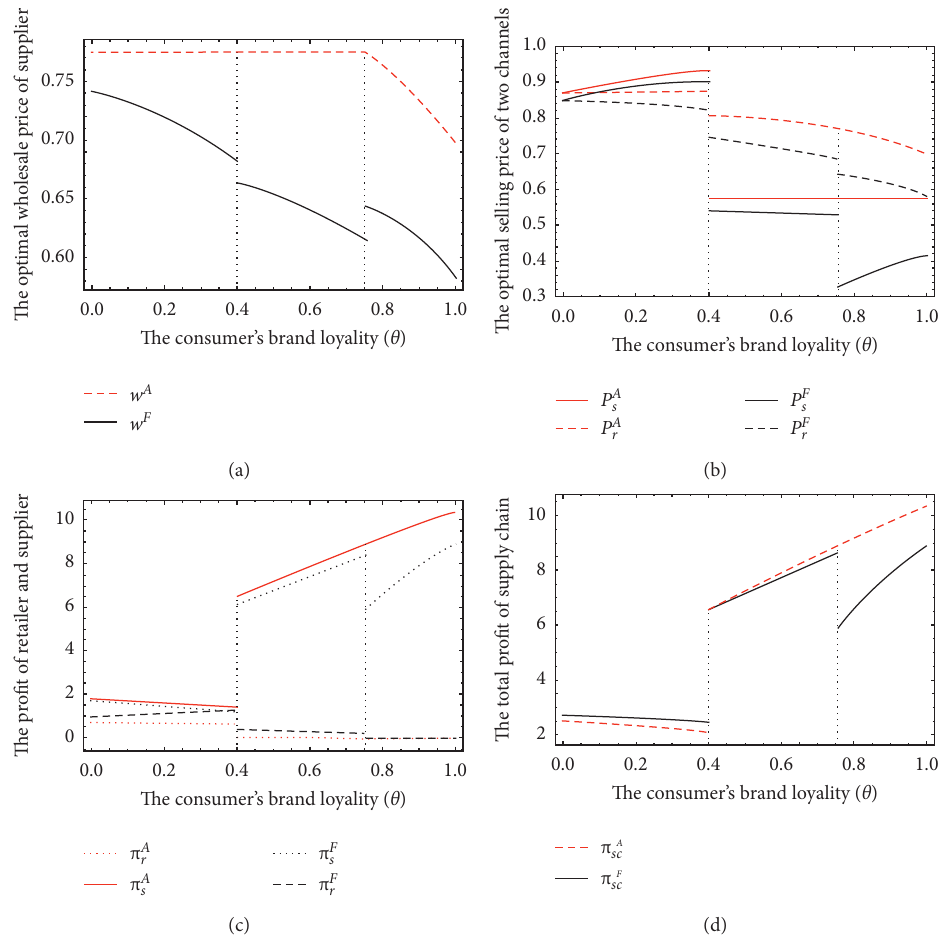
Figure 2: The impact of consumers’ brand loyalty on decisions and profits. (a) The impact of θ on wholesale price. (b) The impact of θ on online price. (c) The impact of θ on participants’ profits. (d) The impact of θ on total profit of supply